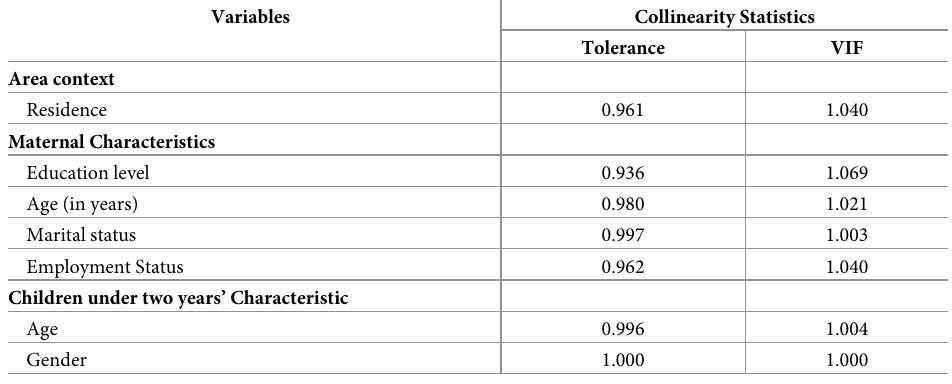
Table 1. The results for the co-linearity test of nutritional status of children under two years in Indonesia (n = 70,293).